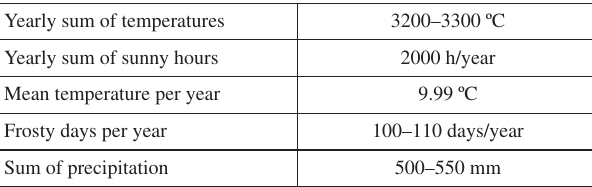
Table 1. Local meteorological data of Pallag